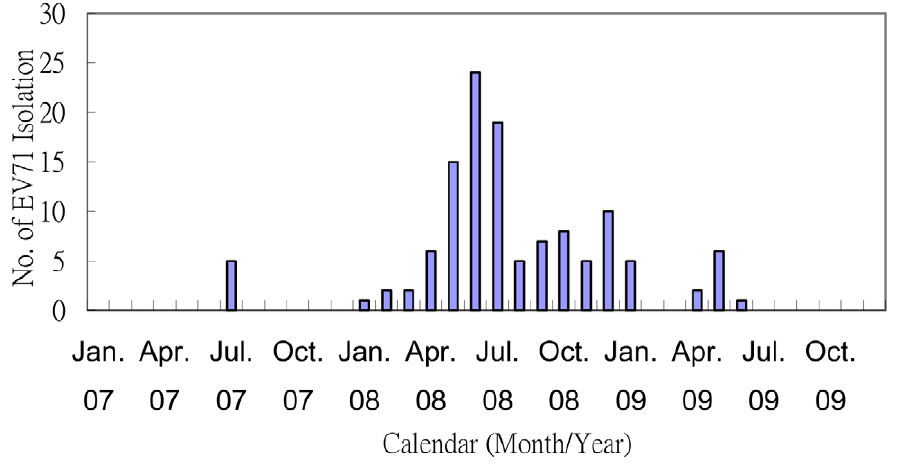
Figure 1. Enterovirus 71 isolation in pediatric inpatients in Chang-Gung Memorial Hospital, Taiwan, 2007–2009.